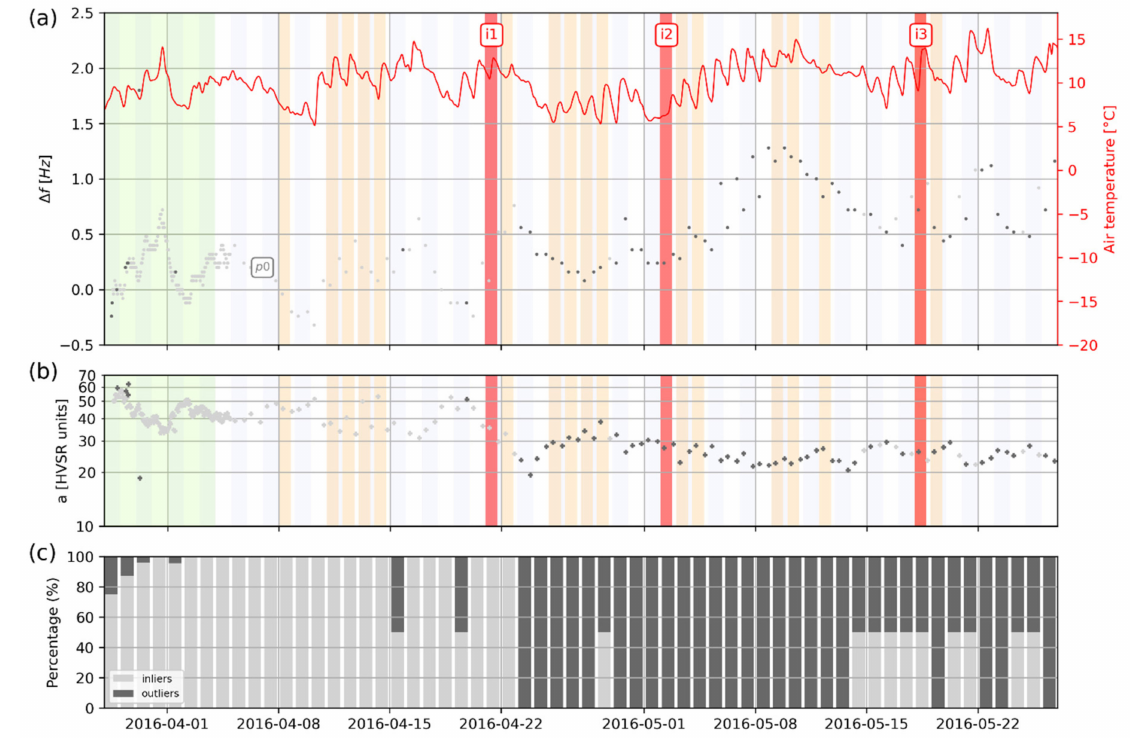
Figure 15. Novelty detection results performed on downsampled time series (dataset D3: p 0 and a HVSR ( p 0 ) only, analyzed together with air temperature). Data were downsampled except during the training period TP (green rectangle in ( a ) and ( b ). Peak frequency p 0 shown in ( a ) has been arbitrarily shifted for the sake of easier comparison. HVSR amplitude a HVSR ( p 0 ) is shown in ( b ). Inlier data are shown in dark gray while outliers are shown in light grey. The training period (TP) at the beginning is underlined in green. Air temperature on-site is shown as red curve in ( a ). Reinforcement work stages are shown in the background: drilling days (light orange) and grout injection (red). ( c ) Respective percentage of inlier and outlier data in the detection